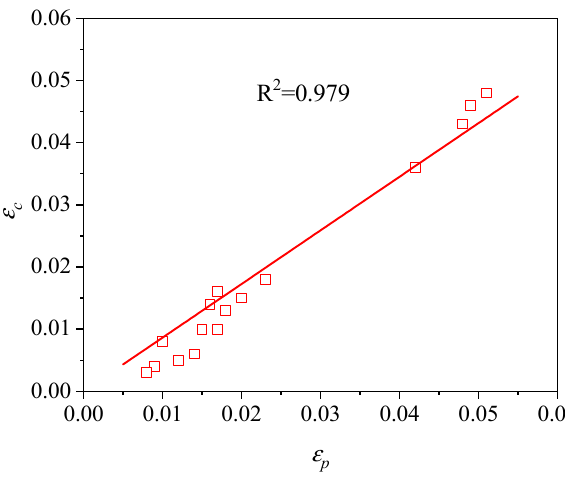
Figure 13. Relationship between the critical strain ( ε c ) and peak strain ( ε p